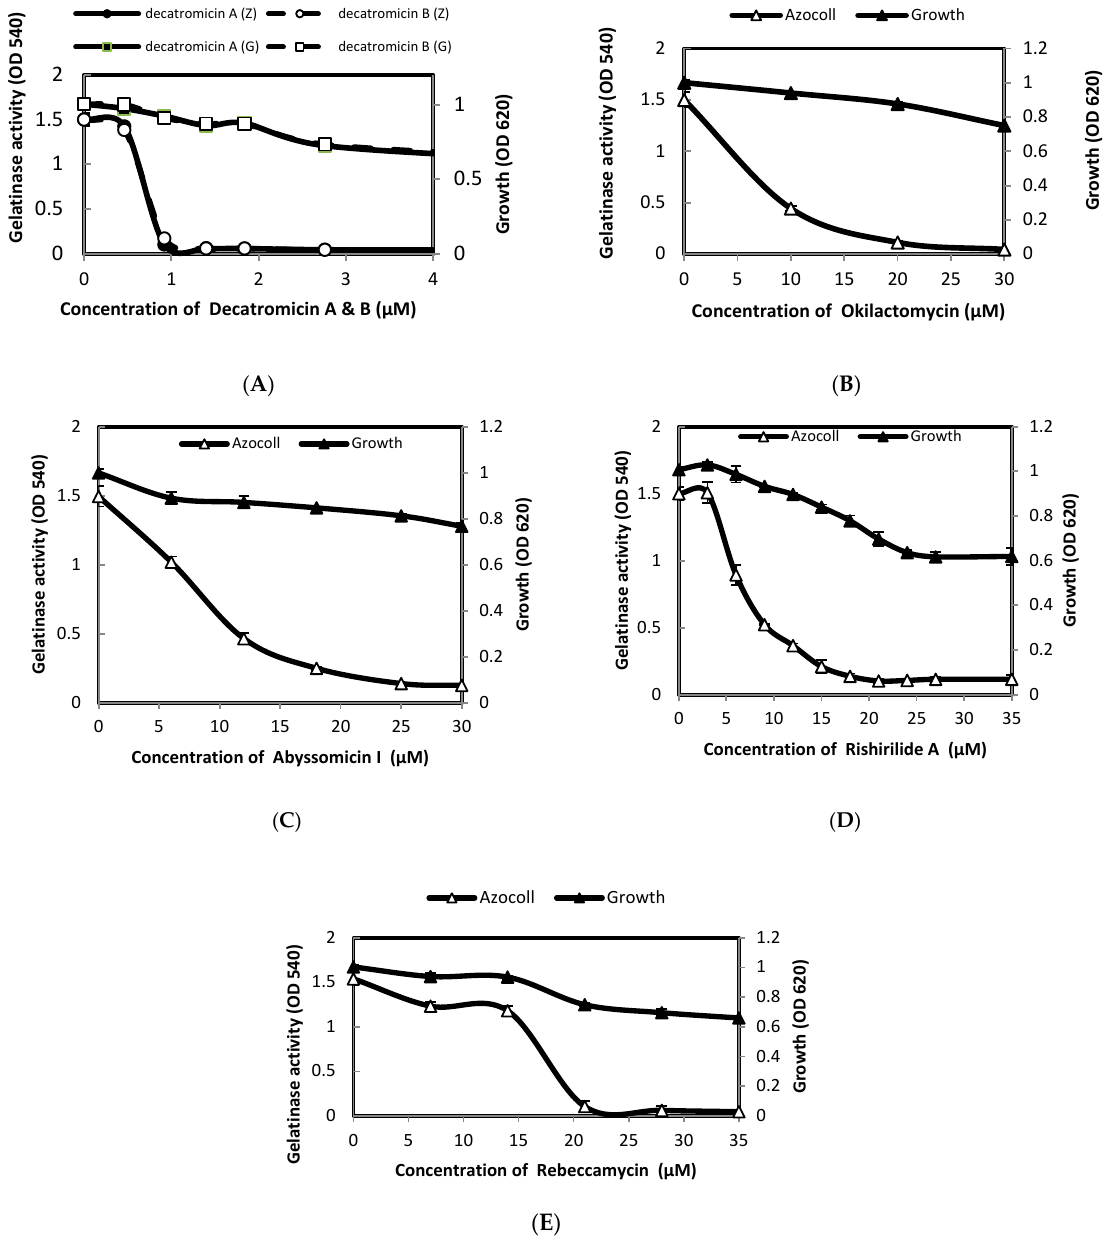
Figure 3. Effect of QS inhibitors on the gelatinase production and growth of E. faecalis . E. faecalis OG1RF was grown for 5 h in the absence and presence of QSIs at the indicated concentrations.